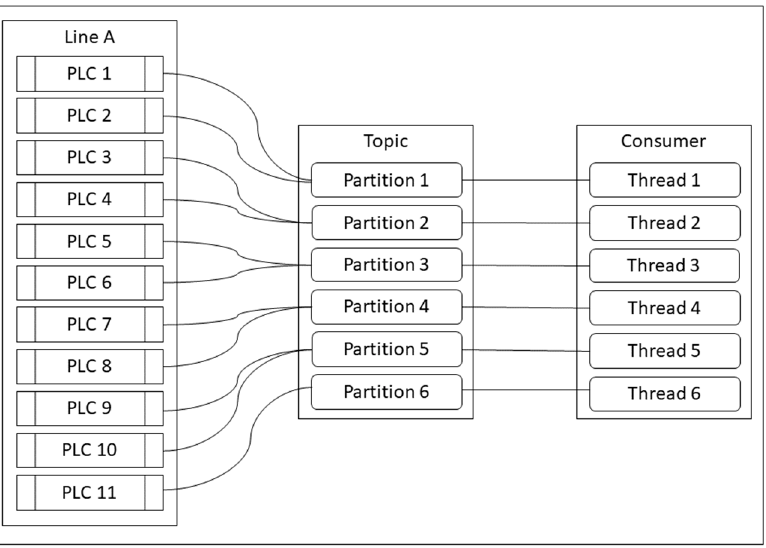
Figure 7. Recommend the number of partitions and threads.